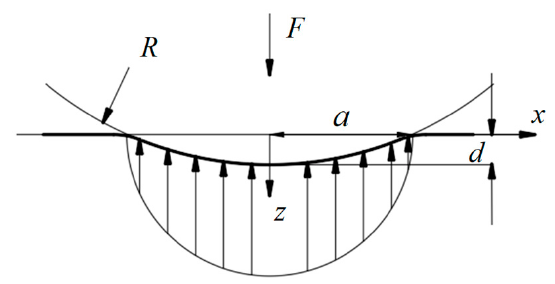
Figure 3. Rigid sphere and elastic half-space contact. Hertz contact model are in parallel contact. The normal pressure, F , and the indentation depth, d , are linearly proportional: